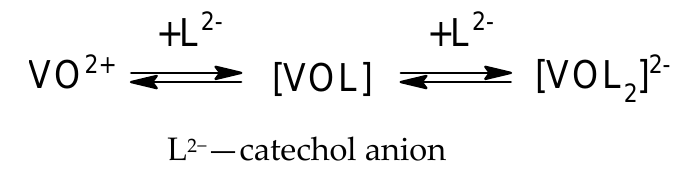
Scheme 2. Oxovanadium(IV) complexes of catechol (L) in aqueous